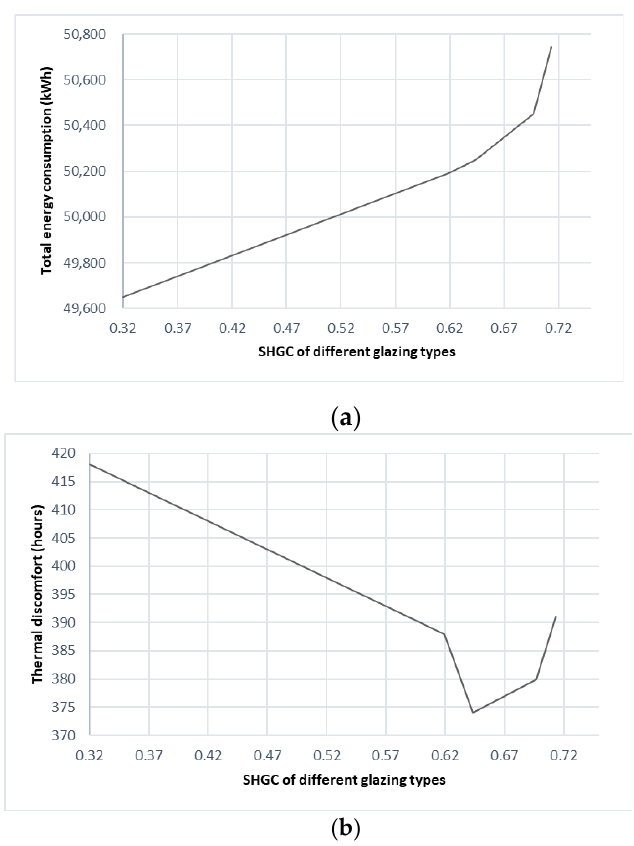
Figure 9. The effect of glazing type on ( a ) energy consumption and ( b ) students’ thermal discom- fort